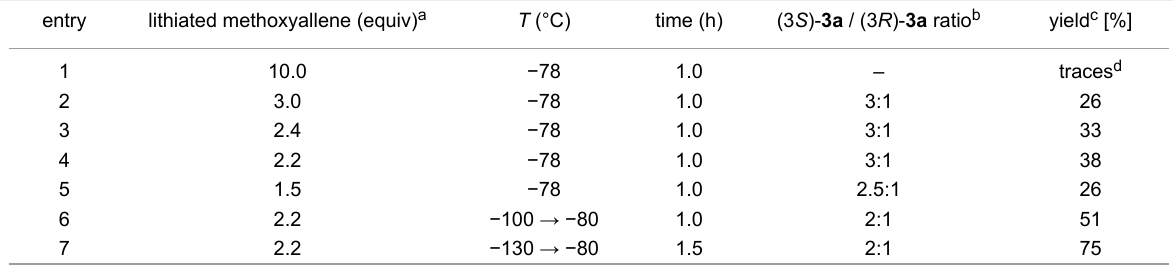
Table 1: Selected reaction conditions of nitrone 1a with lithiated methoxyallene.